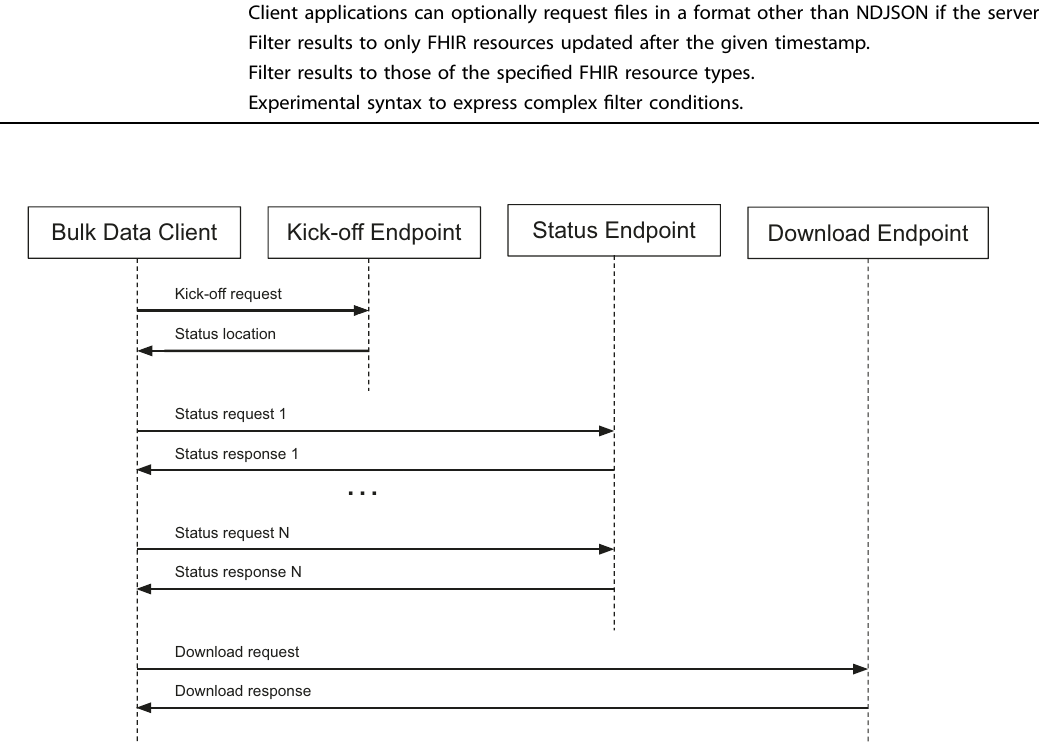
Fig. 1 SMART/HL7 FHIR Bulk Data Work fl ow. The request work fl ow consists of a kickoff request, status requests to a generated status endpoint, and a fi le download request to hosted bulk data fi